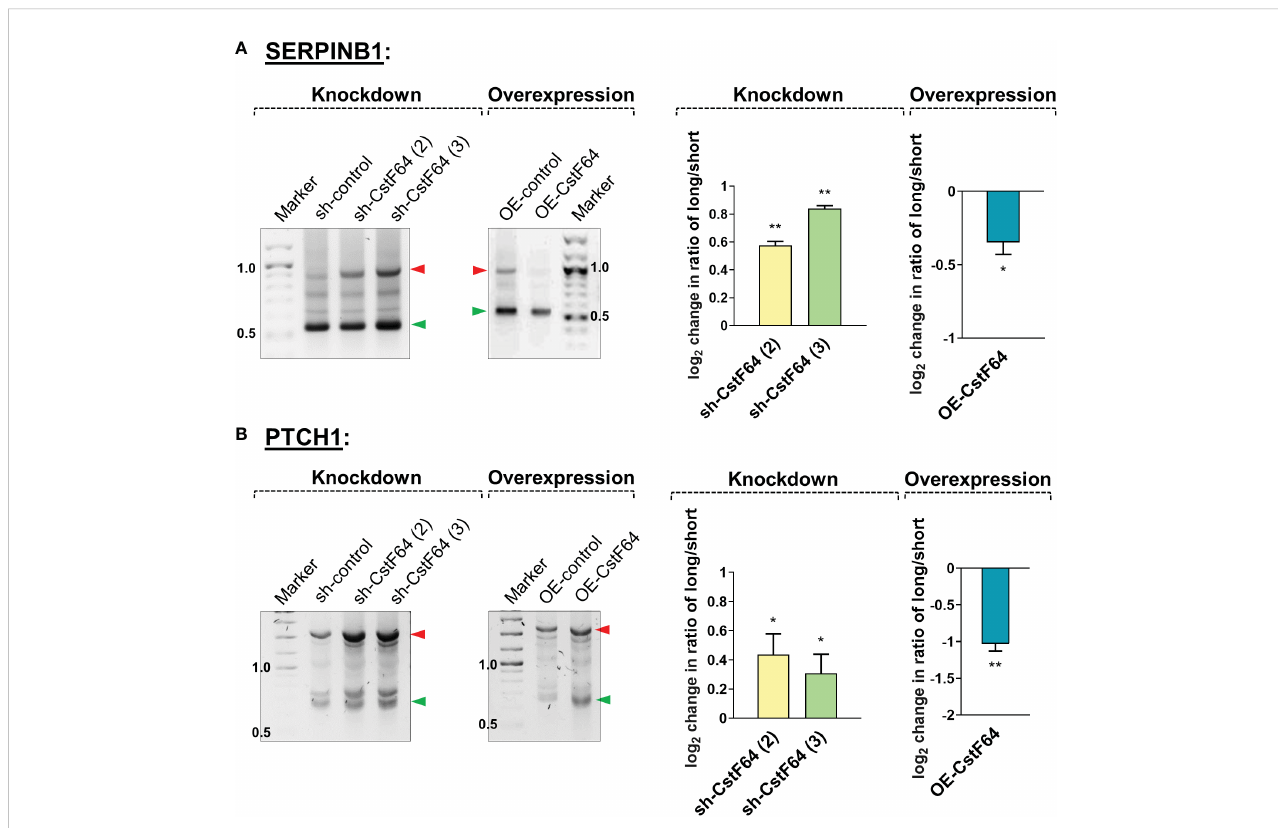
FIGURE 8 Knockdown or overexpression of CstF64 in U937 cells alters APA. Representative 1% agarose gel images for the 3 ′ RACE RT-PCR in U937 cells for shortened genes SERPINB1 (A) and PTCH1 (B) , using gene speci fi c primers at the last exon-exon junction and a common reverse anchor primer. In each sub fi gure, the effect of depletion (knockdown) of CstF64 and the effect of overexpression of CstF64 are indicated, using the same treatment protocols as described in Figure 7. Normalized intensities of long and short bands for each PCR were quanti fi ed and a long/short ratio determined and normalized to the shRNA or OE control. The corresponding graphs (right) represents mean ± SE from at least two independent experiments. P value <0.05 was considered signi fi cant, where * = P ≤ 0.05; ** = P ≤